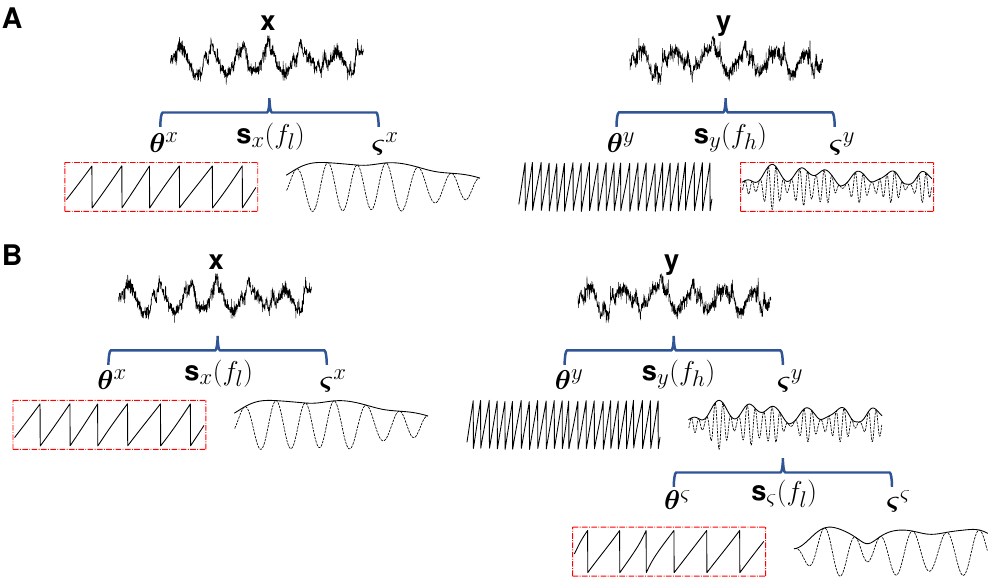
Figure 1. ( A ) The conventional approach to capture directed phase-amplitude interactions through TE consists of estimating TE from the instantaneous phase and amplitude time series that were extracted at frequencies f l and f h , respectively. ( B ) Our approach implies a further step, comprising the extraction of the phase of the amplitude time series at frequency f l , to reformulate the problem as a phase TE estimation